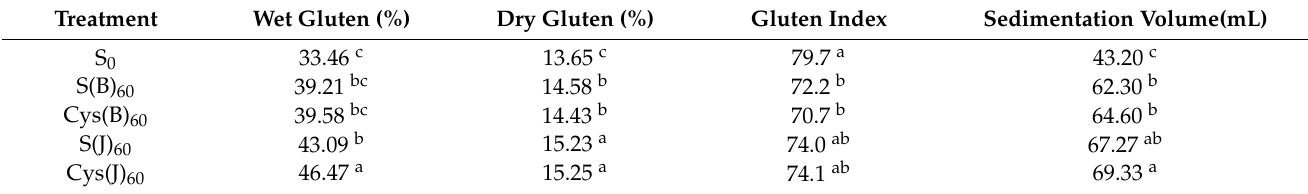
Table 3. Effects of cysteine and inorganic sulfur application at different stages on gluten indices and sedimentation volume of flour.